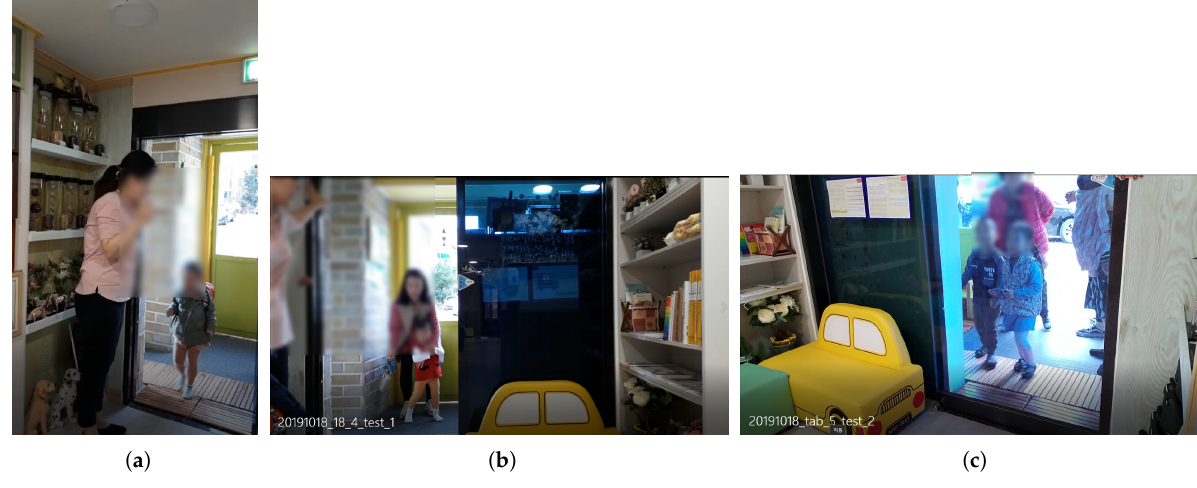
Figure 9. Actual captured images in Figure 8: ( a ) smartphone 1; ( b ) smartphone 2; ( c ) tablet PC. Second, as shown in Figure 10, the camera of the tablet PC (front) and the camera of the mobile phone (rear) were installed in a position near the front of the entrance door. The test video was filmed for about two and a half hours, from 8:00 to 10:30 a.m., when children come to the daycare center. The camera installation results are shown in Figure 11. The front camera of a smart device is more effective in children’s face recognition than the rear camera because it can arouse children’s interest. When using a smart device’s camera, which uses a movable camera, the location may change or the camera function may be turned off when touched by children. However, if the front camera is used, children can see their reflection on the screen as they pass through the door, so the probability of securing the children’s front faces increases by arousing their interest.